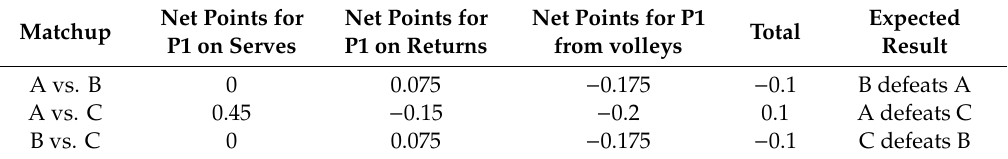
Table 4. Expected points and results from each matchup in a simple tennis model. Net points are the average expected points earned for the first player listed in the matchup. Net Points for Net Points for Net Points for P1 Expected Matchup Total P1 on Serves P1 on Returns from volleys Result A vs.